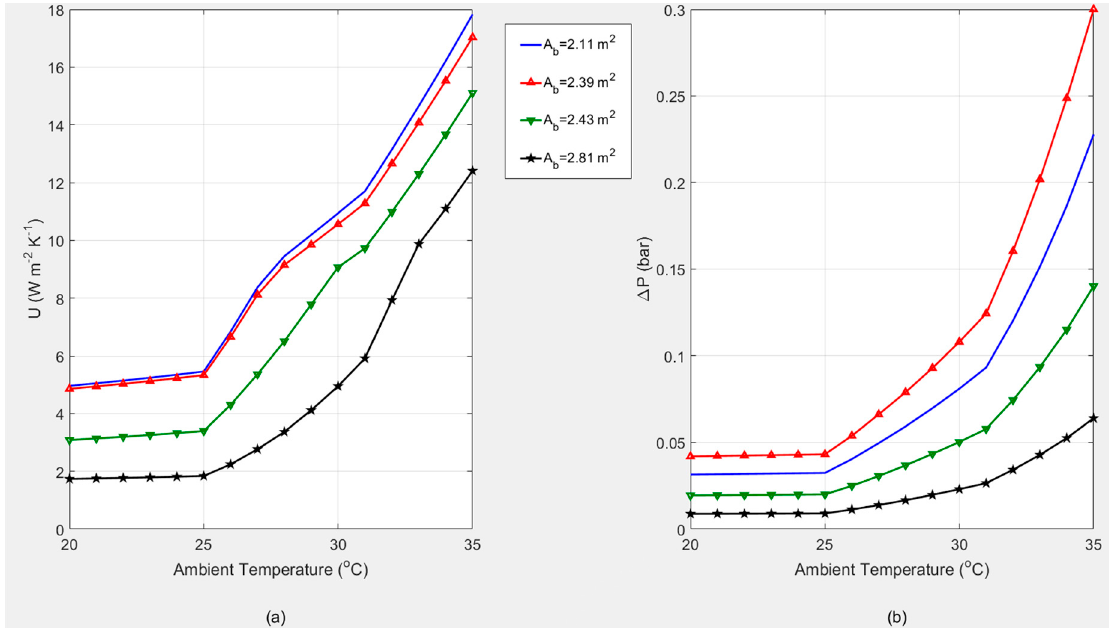
Figure 11. Comparison between potential heat exchangers in di ff erent ambient temperatures of ( a ) the overall heat transfer coe ffi cient; and ( b ) the refrigerant pressure